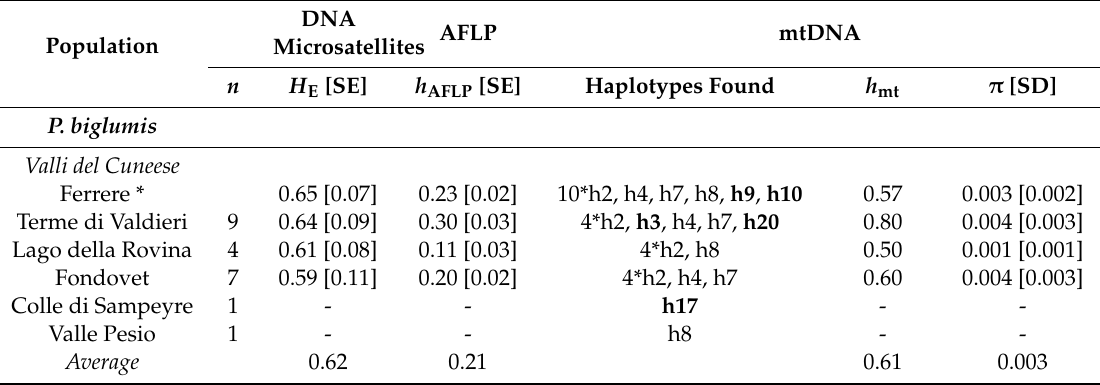
Table 1. Genetic diversity in Polistes biglumis and Polistes atrimandibularis populations in DNA microsatellite, amplified fragment length polymorphism (AFLP), and mitochondrial markers; n is the sample size for nuclear markers. H E is expected heterozygosity according to Hardy-Weinberg equilibrium and h AFLP haplotype diversity, both averaged across loci for each population; h mt is haplotype diversity and π is nucleotide diversity. Values of H E and h AFLP and the average of h mt and π in Valsesia were calculated for populations with sample size n > 2. P. biglumis populations parasitized by P. atrimandibularis are marked with an asterisk (*). Note that the haplotype codes in P. biglumis and P. atrimandibularis do not refer to the same haplotypes. Singleton haplotypes are in